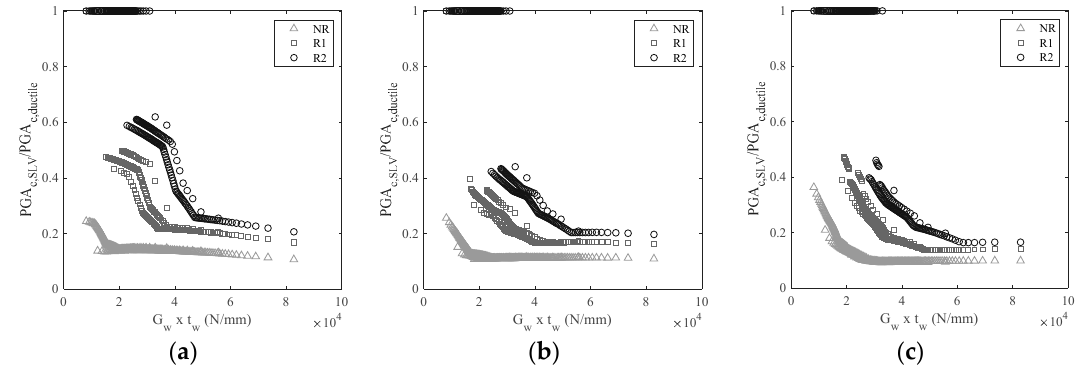
Figure 12. Variation of PGA c,SLV /PGA c,ductile with G w t w for ( a ) three-storey, ( b ) five-storey, and ( c ) seven-storey buildings. The effect of retrofit solution FRP-only is also represented.